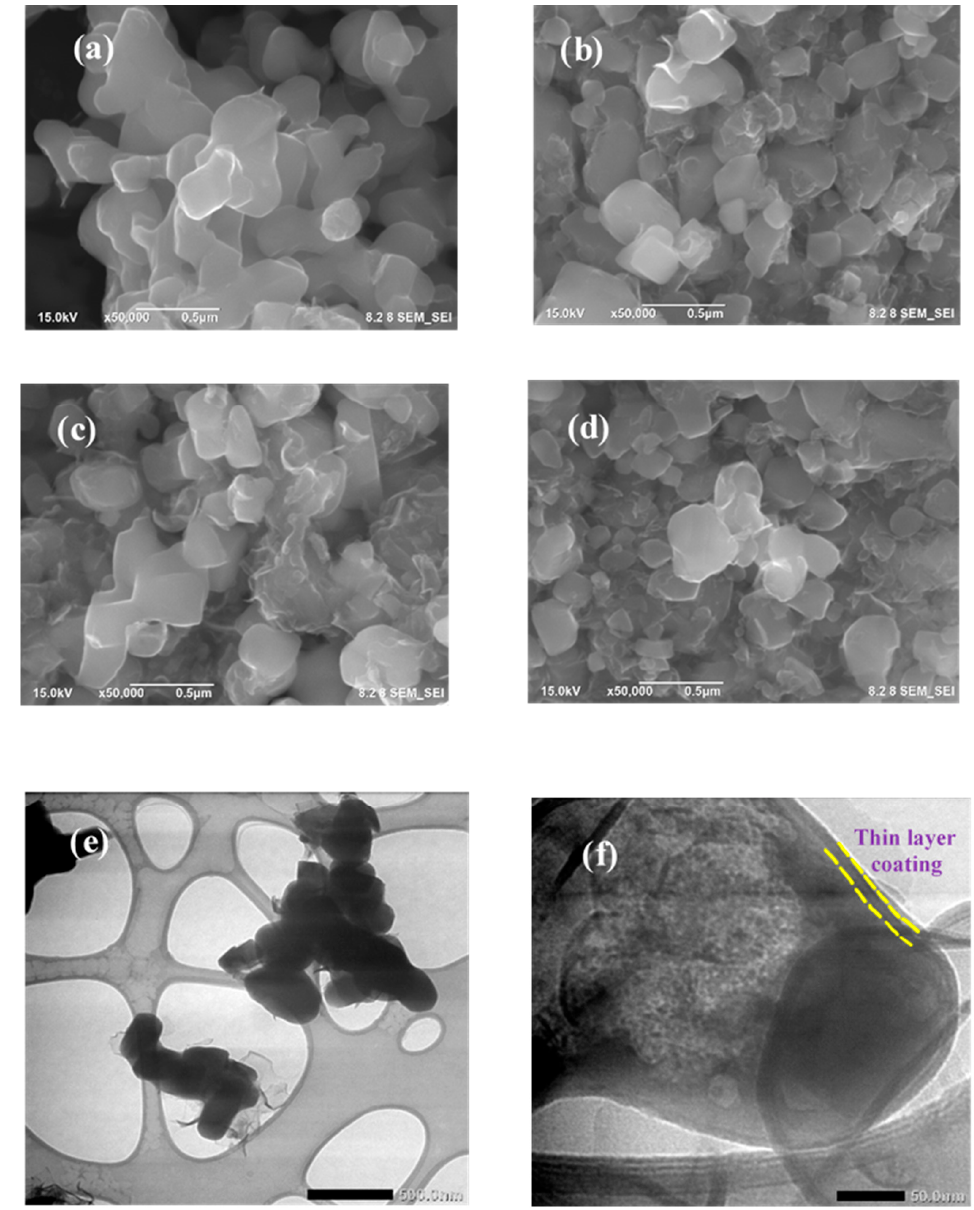
Figure 2. SEM images of ( a ) pristine LTO, ( b ) LTO 0.1F, ( c ) LTO 0.15F, ( d ) LTO 0.2F; TEM images of LTO 0.2F ( e ) low and ( f ) high magnification.